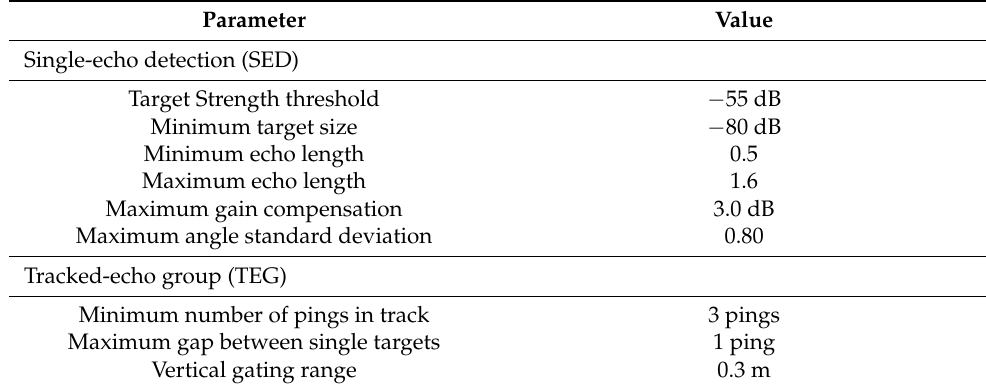
Table 2. Single-echo detection (SED) and tracked-echo group (TEG) parameters used in Sonar5